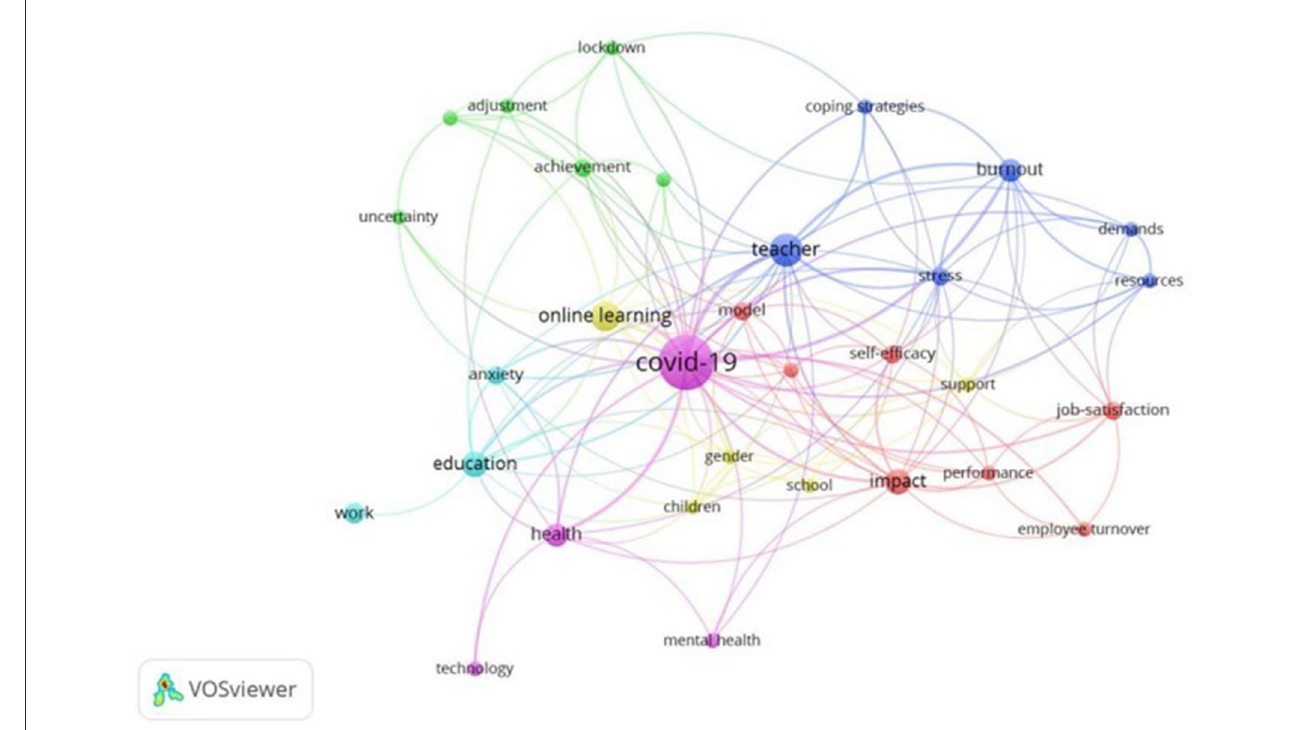
FIGURE9 Bibliographic coupling analysis for co-word networks ( ≥ 2 co-word networks).